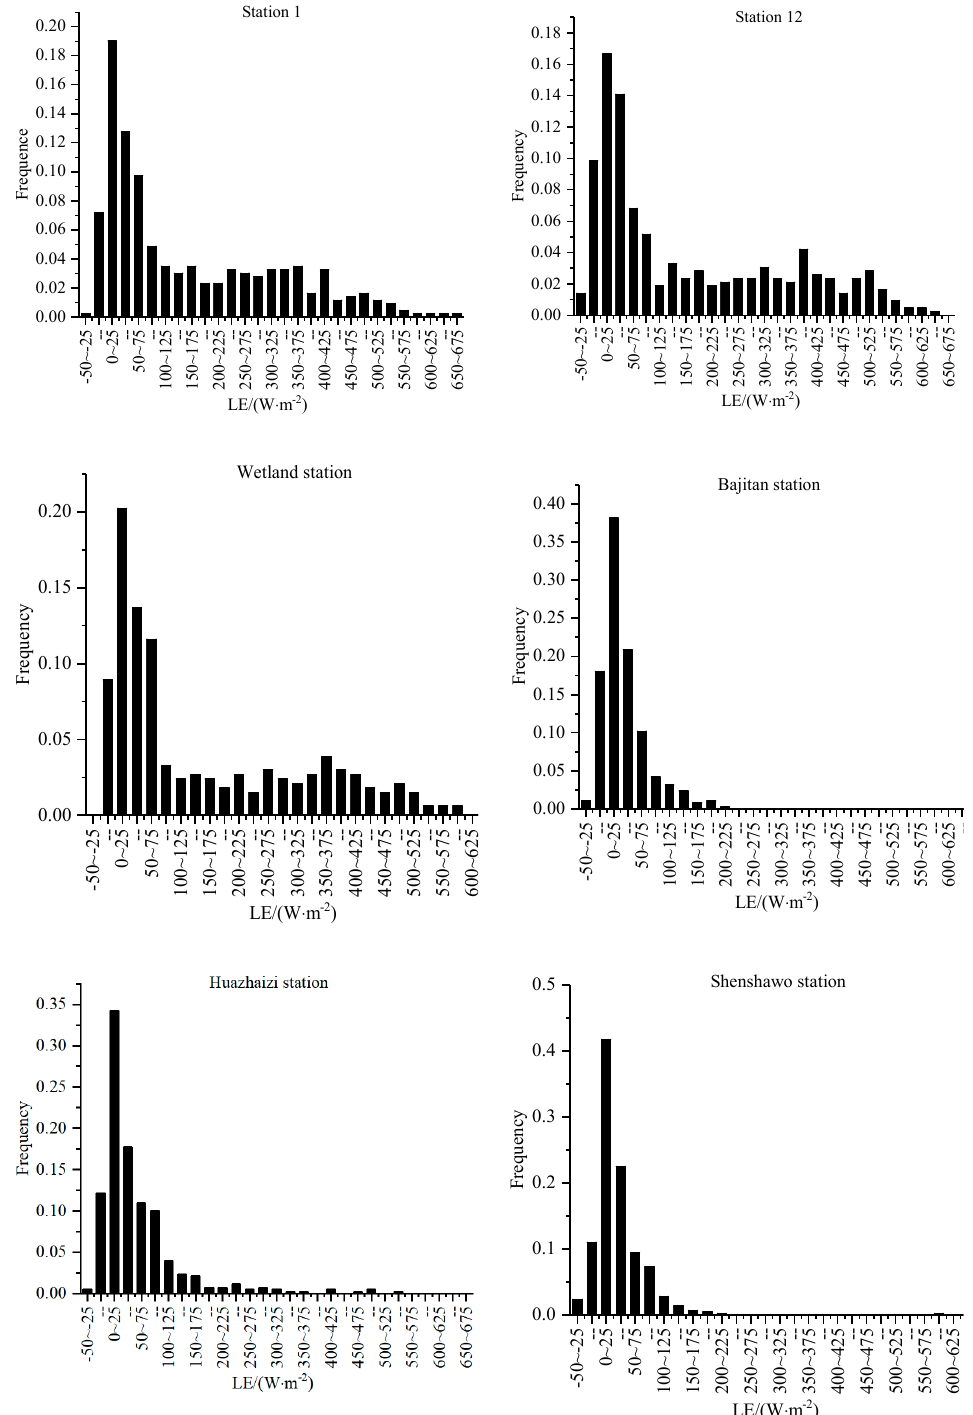
Figure 5. Histogram of LE frequency distribution for 9 days under different underlying surface types.